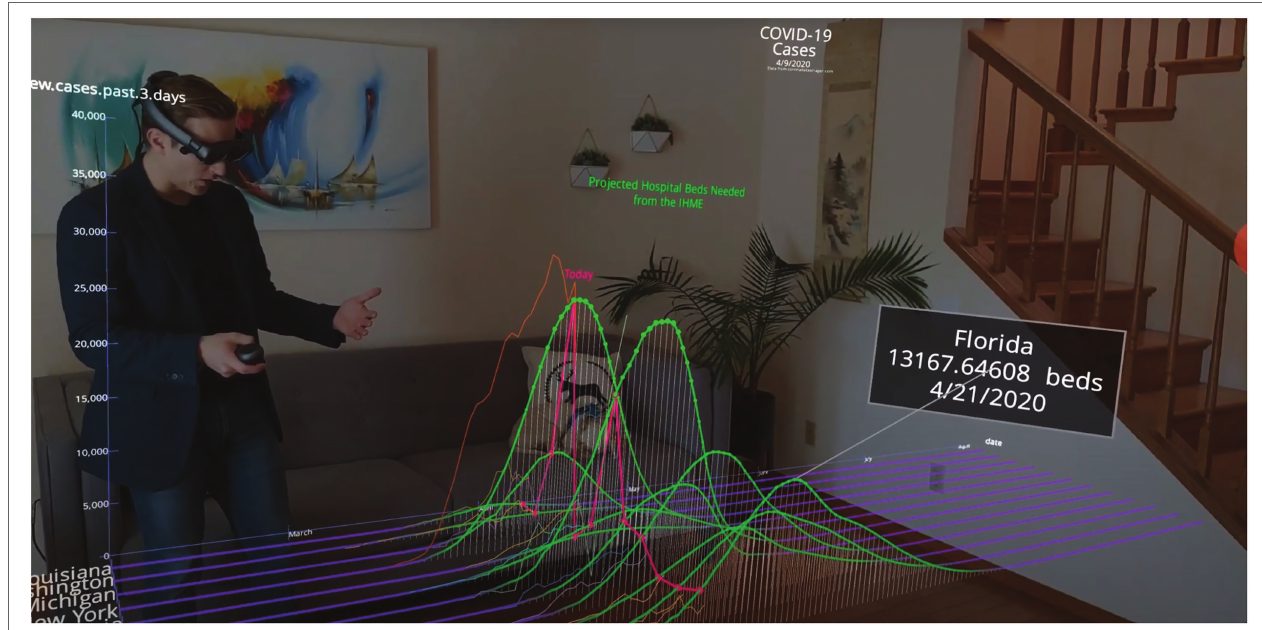
FIGURE 2 | Example of a predictive simulation of augmented reality (AR) Covid-19 data for multiple states in the United States. The X -axis is time, the month of March is visible by the presenter’s leg; the Y -axis is number of new cases based on previous 3 days, and the Z -axis is actually a series of lines representing multiple individual states in the United